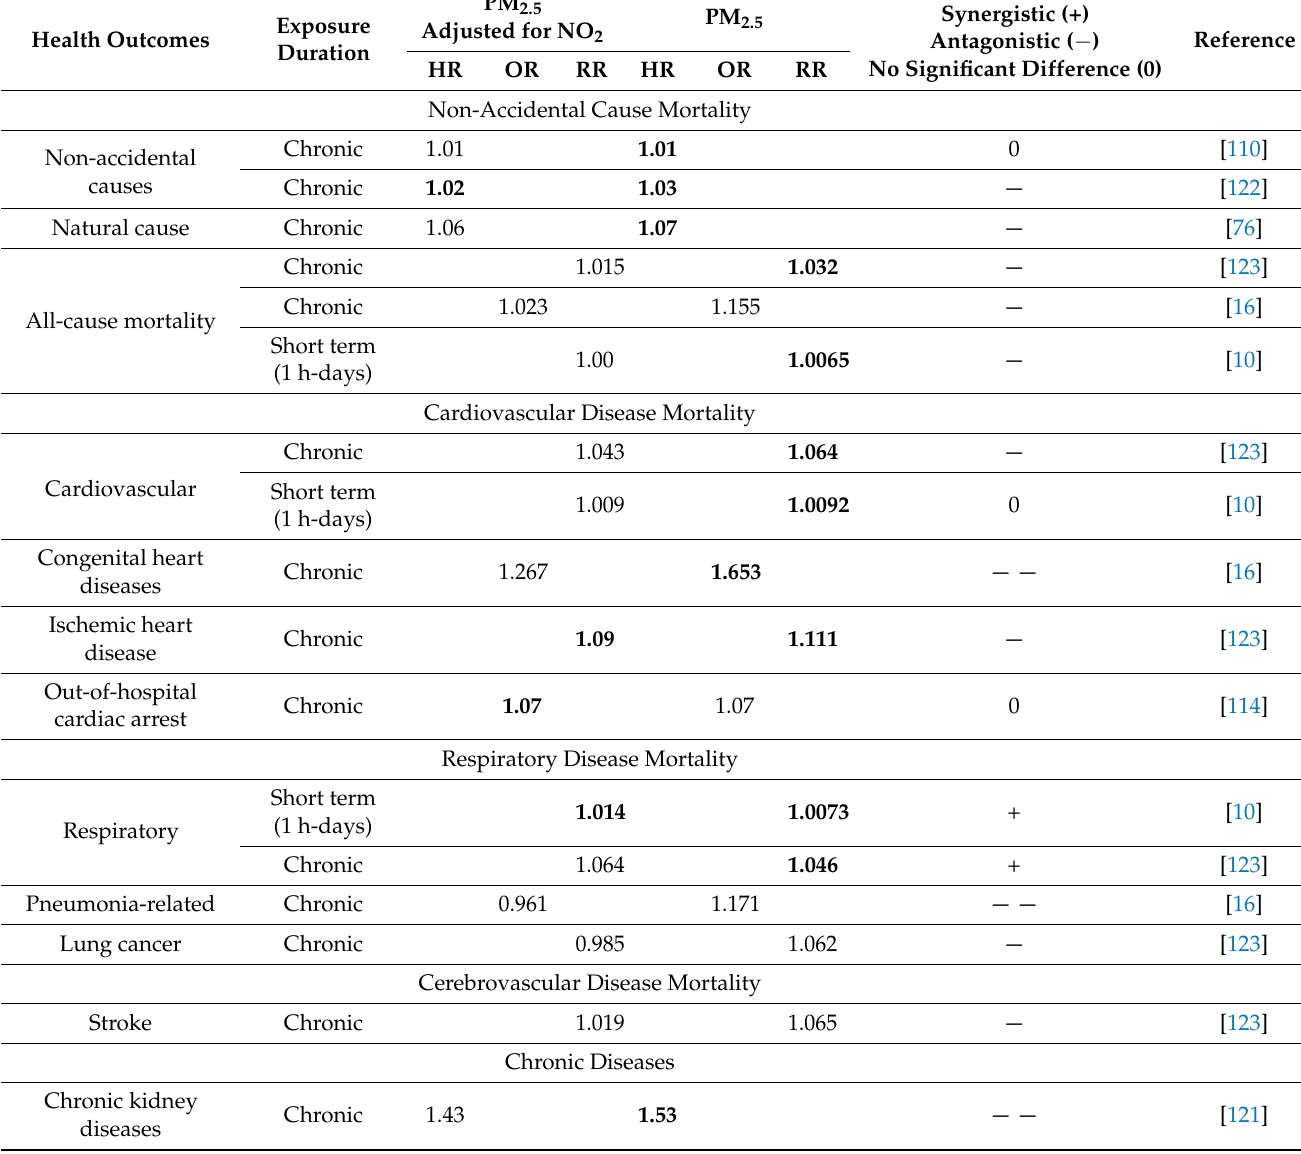
Table 5. Risk ratio (RR), odds ratio (OR), and hazard ratio (HR) with corresponding health effects linked to PM 2.5 exposure alone and adjusted for NO 2